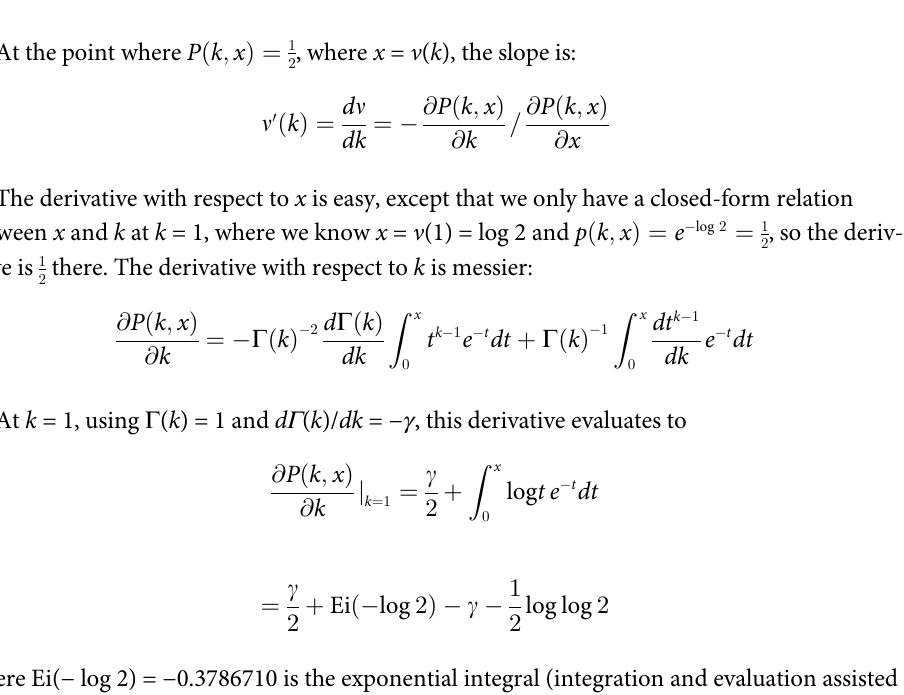
Fig 5. New bounds and their margins, premultiplied by 2 1/ k . The lower bounds ν Γ , ν upper bound ν U (dashed) are shown in red over the ideal median (black heavy dots), with their absolute errors in blue, all premultiplied by 2 1/ k to reduce the required plot range. The approximation ν 1 , which is not a bound, is also shown; note that its error curve changes from solid to dashed at the cusp, while the margins for ν log scale) where the margins graze zero but do not change sign. The k parameters at these cusps correspond to the sloped black lines indicated in the previous two